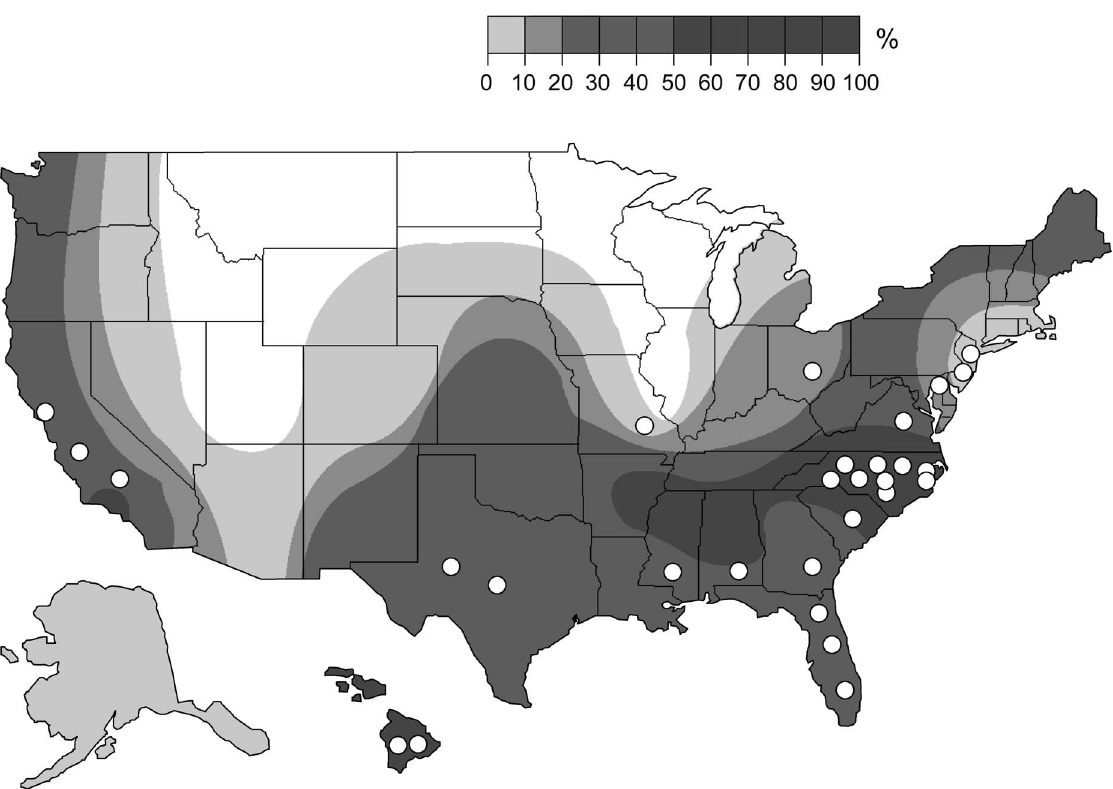
Figure 1. Distributions of collection sites and B.henselae . Bed bug collection sites (circles, N =29) superimposed on a distribution map showing the percentage of pet cats with B. henselae antibodies from 33 geographic regions throughout the U.S. (adapted from Jameson et al. 1995 with permission from Oxford University Press). The highest seroprevalence of B. henselae is in warm, humid areas, especially in the southeastern U.S.